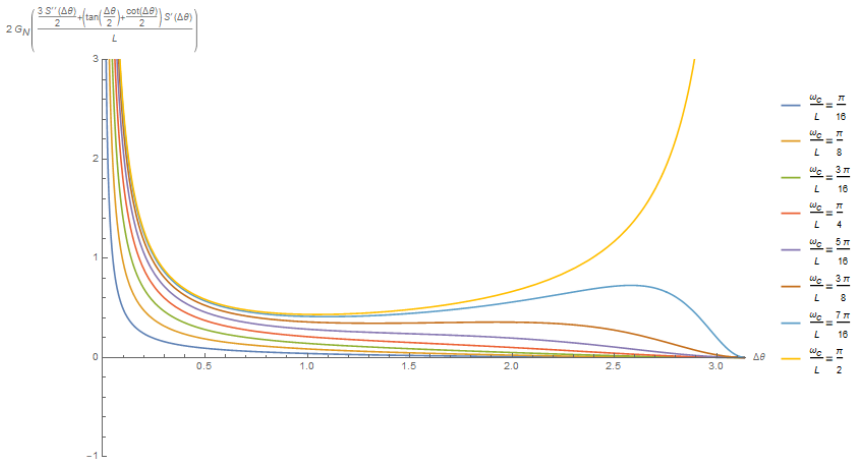
Figure 11 . The boosted strong subadditivity is strongly violated for any radial slice.